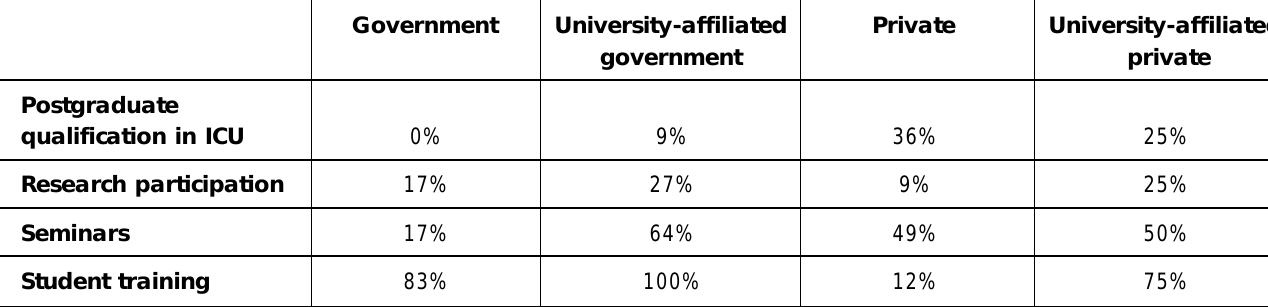
Table 2: Training and educational profiles of respondents in South African